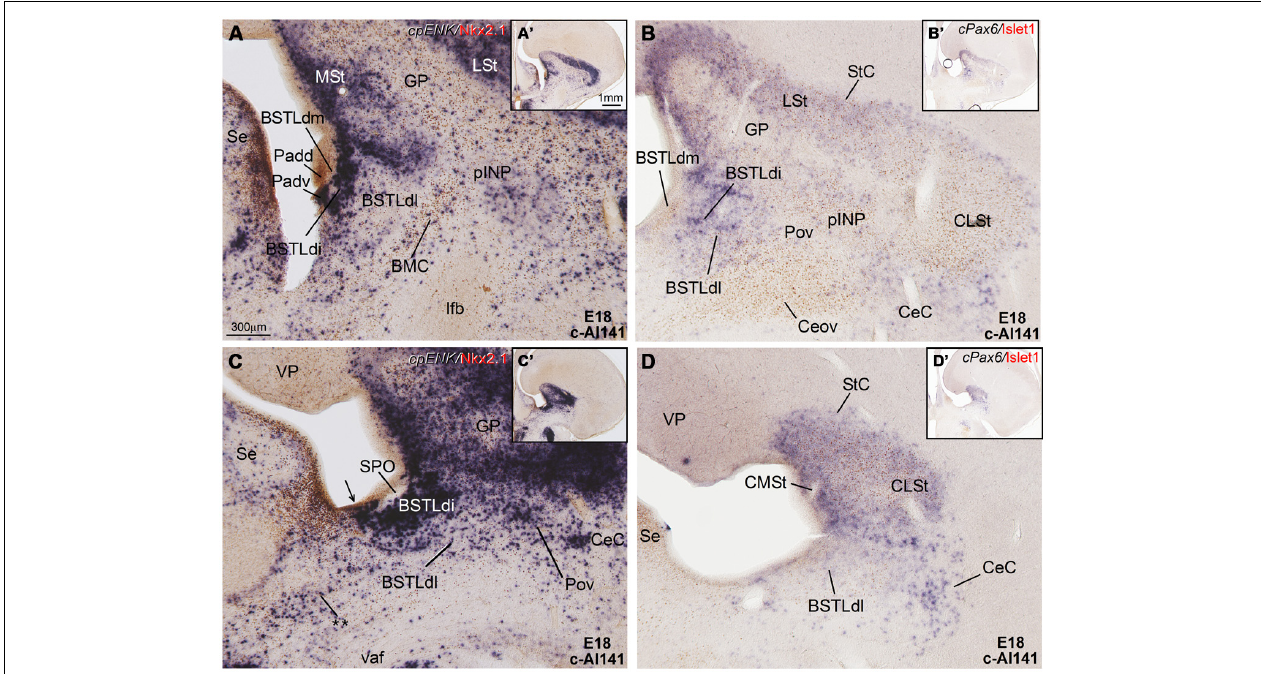
FIGURE 7 | Expression of cpENK and other genes in the central extended amygdala of chicken embryos at late stages. (A–D) Digital images of frontal sections through the telencephalon of a chicken embryo (E18, case c-Al141) hybridized for cpENK or cPax6 (dark blue signal) and immunostained (brown) for Islet1 or Nkx2.1. (A–D) are high-magnification images of the sections shown in (A (cid:2) –D (cid:2) ) , respectively. The black arrow in (C) is pointing to a ventral subdivision of the dorsal Padv, where cells are expressing cpENK and Nkx2.1 are overlapped.